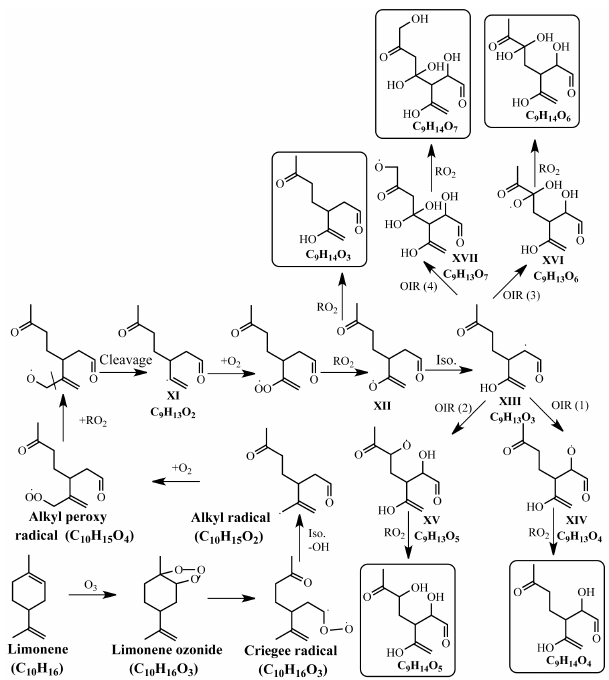
Fig. 3. Illustration depicting the formation of O homologous se- ries. Alkoxy radical resulting from the Criegee radical could con- vert to alkyl radical (XI) by cleavage. Oxygen-increasing-reactions (OIR, O 2 addition to the alkyl radical → reaction between RO 2 rad- icals → isomerization of the alkoxy radical) produce an alkyl rad- ical (XIII) with an additional oxygen atom. Further OIR sequences result in alkoxy radicals labeled as XIV, XV and XVI and XVII. They are transformed to neutral molecules by reactions with RO 2 and comprise the O homologous series.